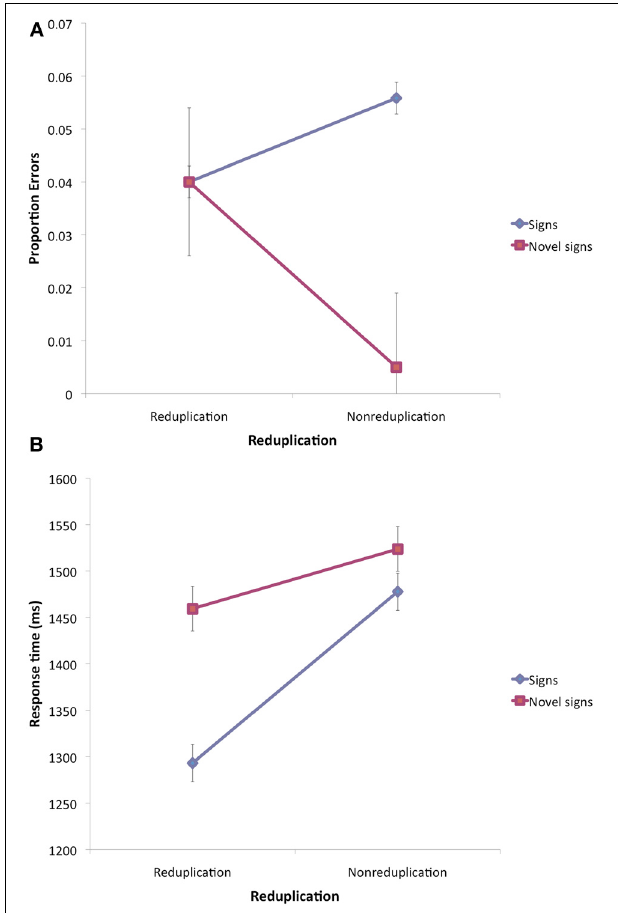
FIGURE 8 | Lexical decision results for ASL signs and novel signs with handshapes in Experiment 4. Note: Error bars are 95% confidence intervals for the difference between the